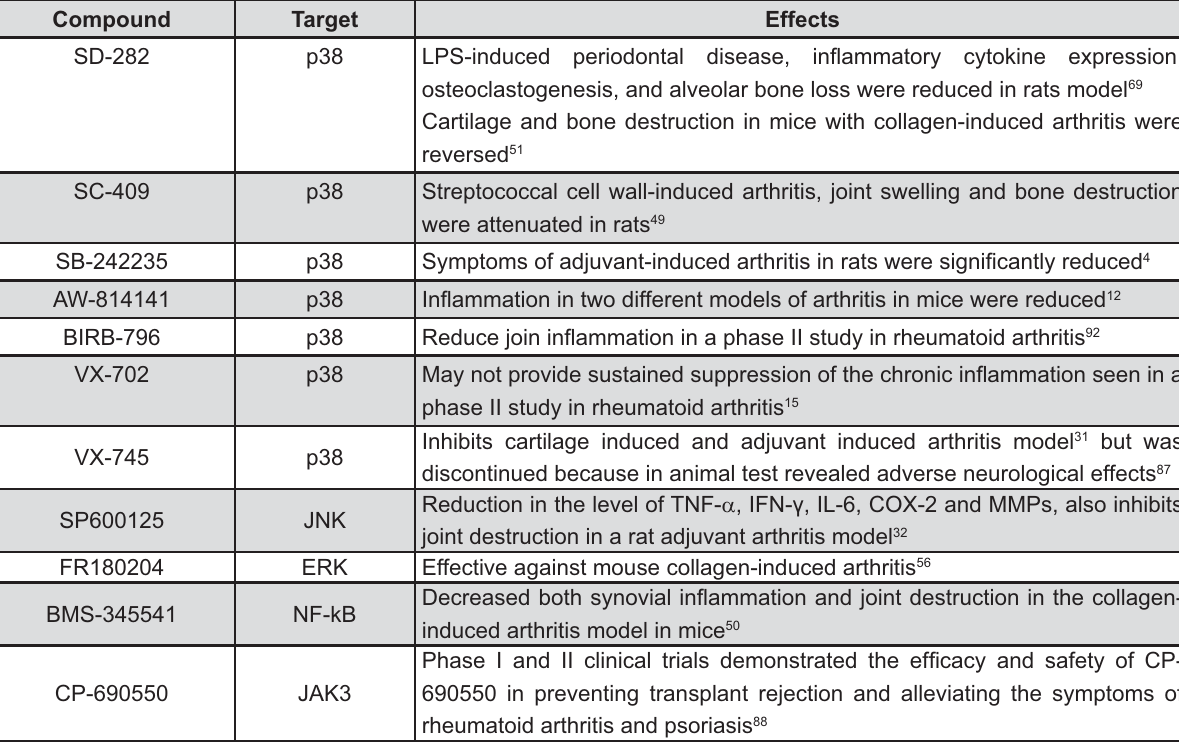
Figure 4- Pharmacological compounds with potential host-modulation